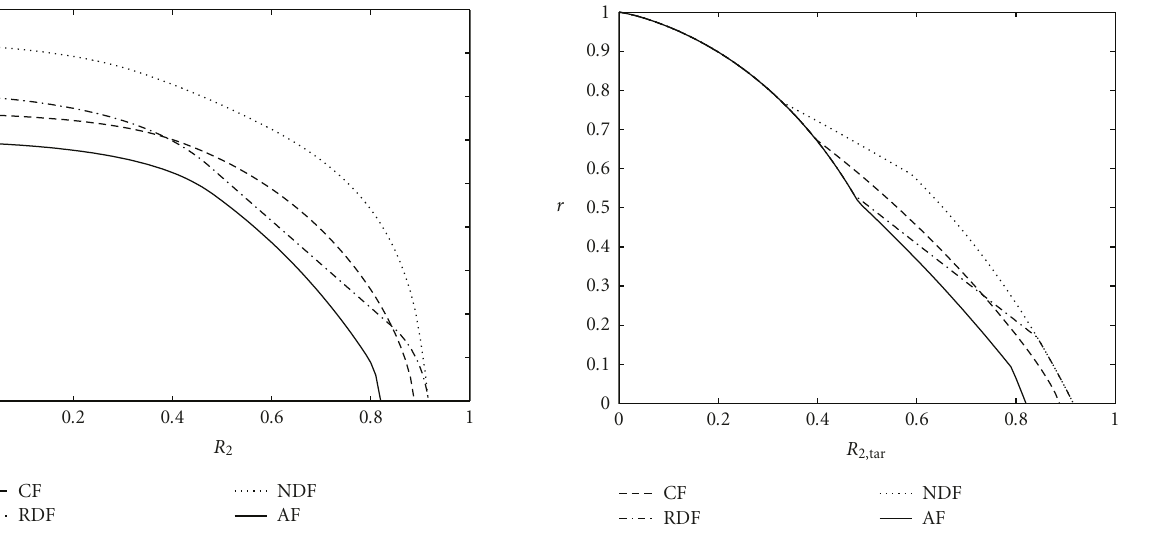
Figure 9: Resource allocation from the jointly optimal algorithm in Scenario